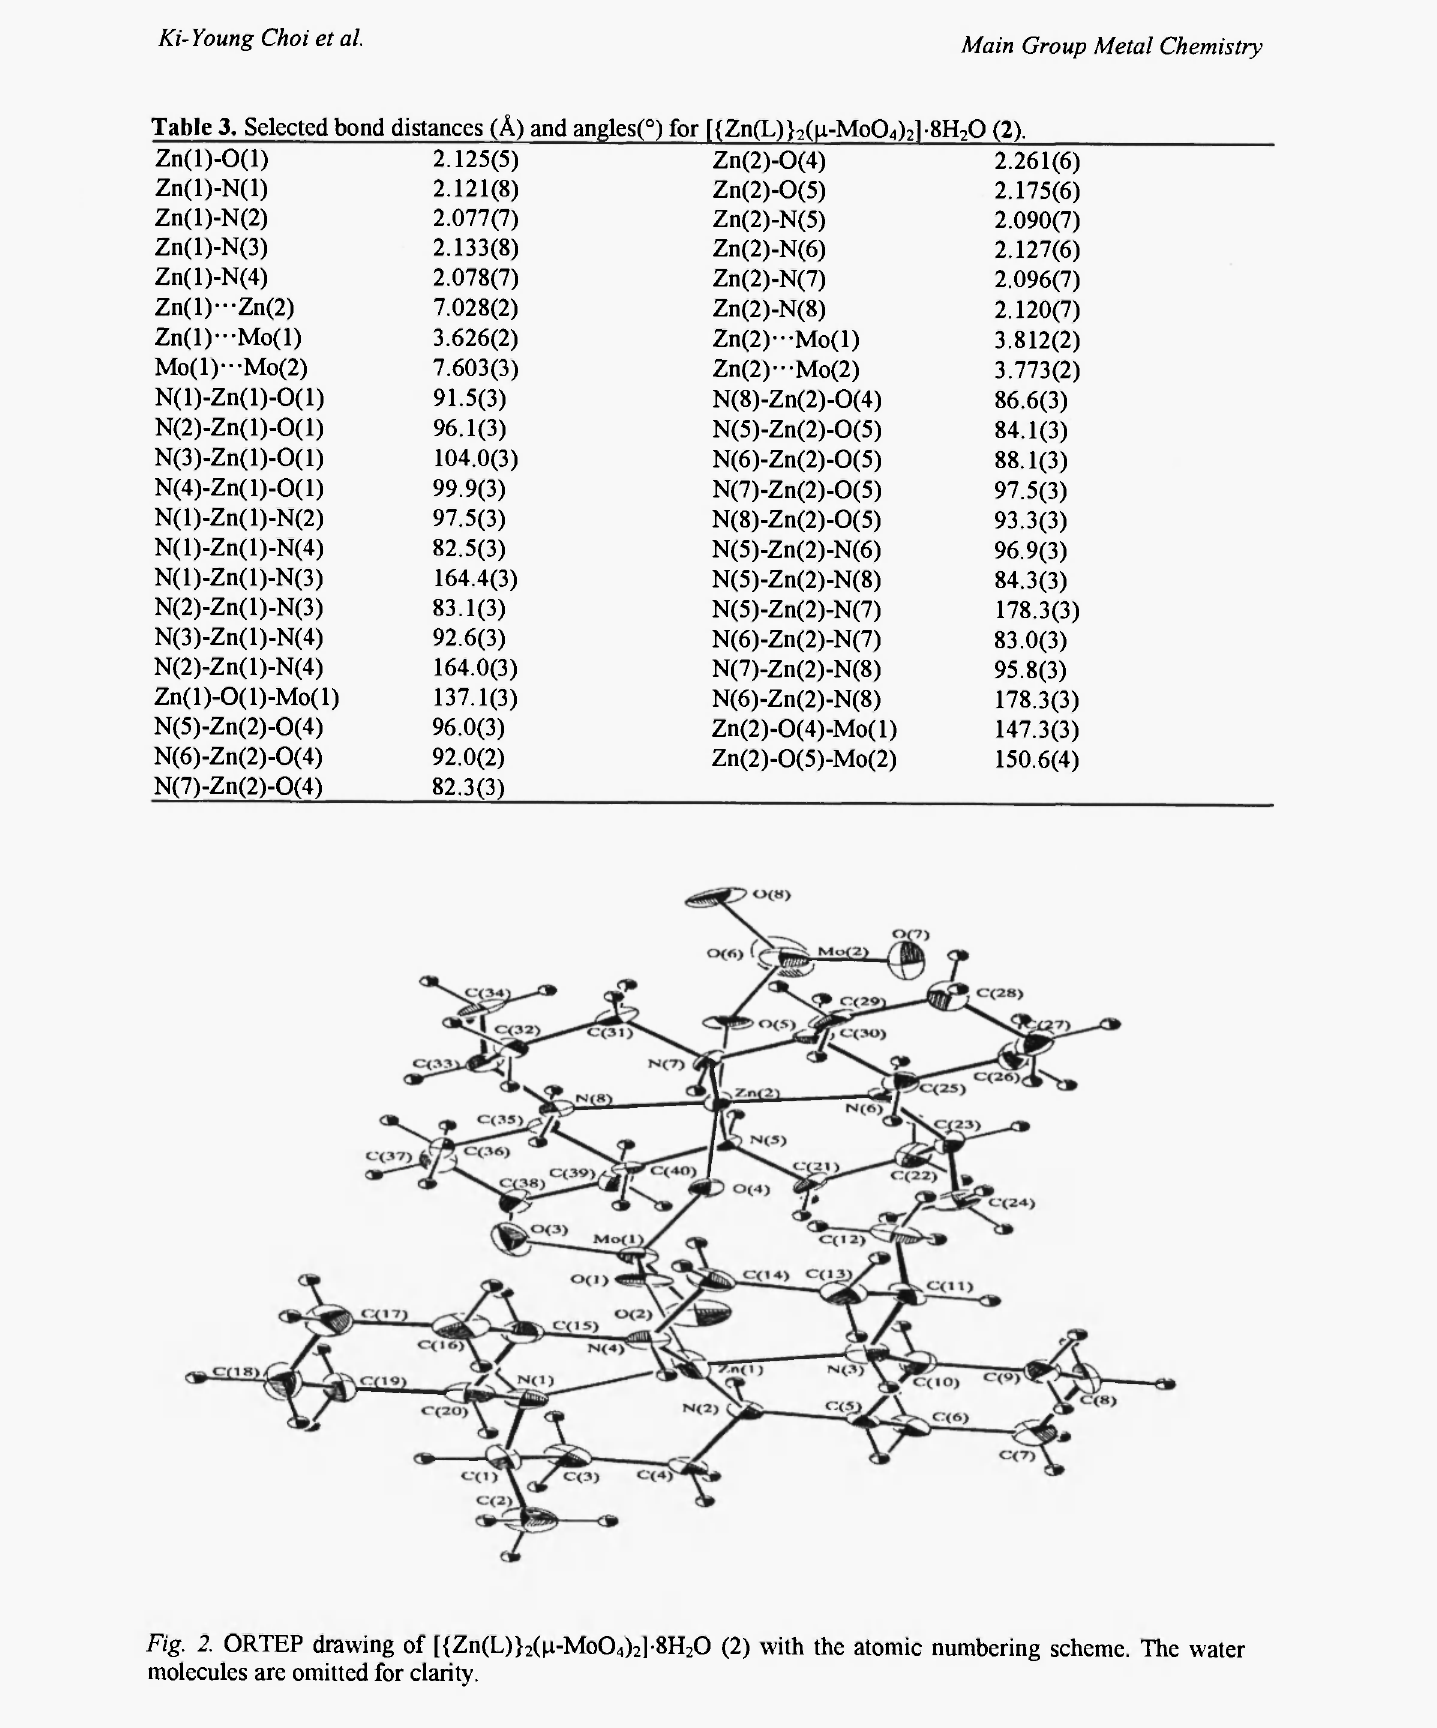
Table 3. Selected bond distances (A) and anglesQ for [{Ζη^)} 2 (μ-Μο0 4 ) 2 ]·8Η 2 0 (2).